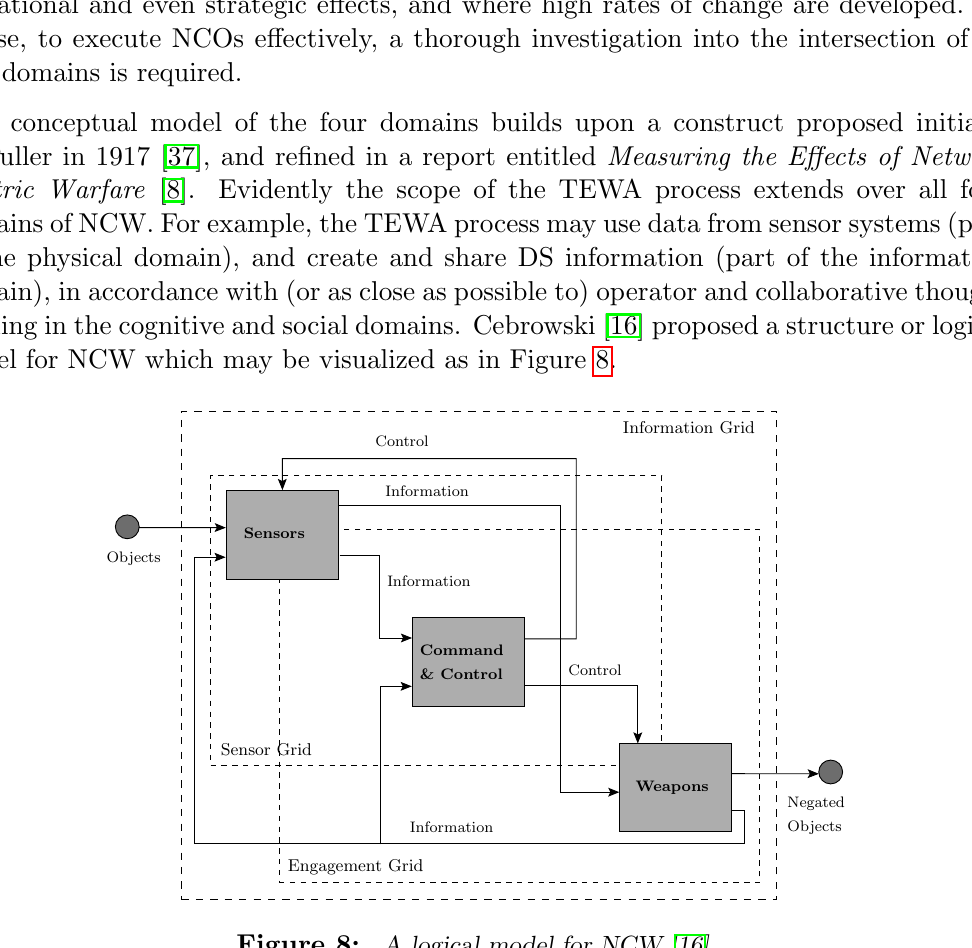
Figure 8: A logical model for NCW